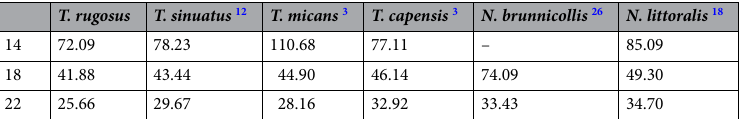
Table 4. Comparison among the estimated developmental times of T. rugosus at three constant temperatures for five forensically important Silphid